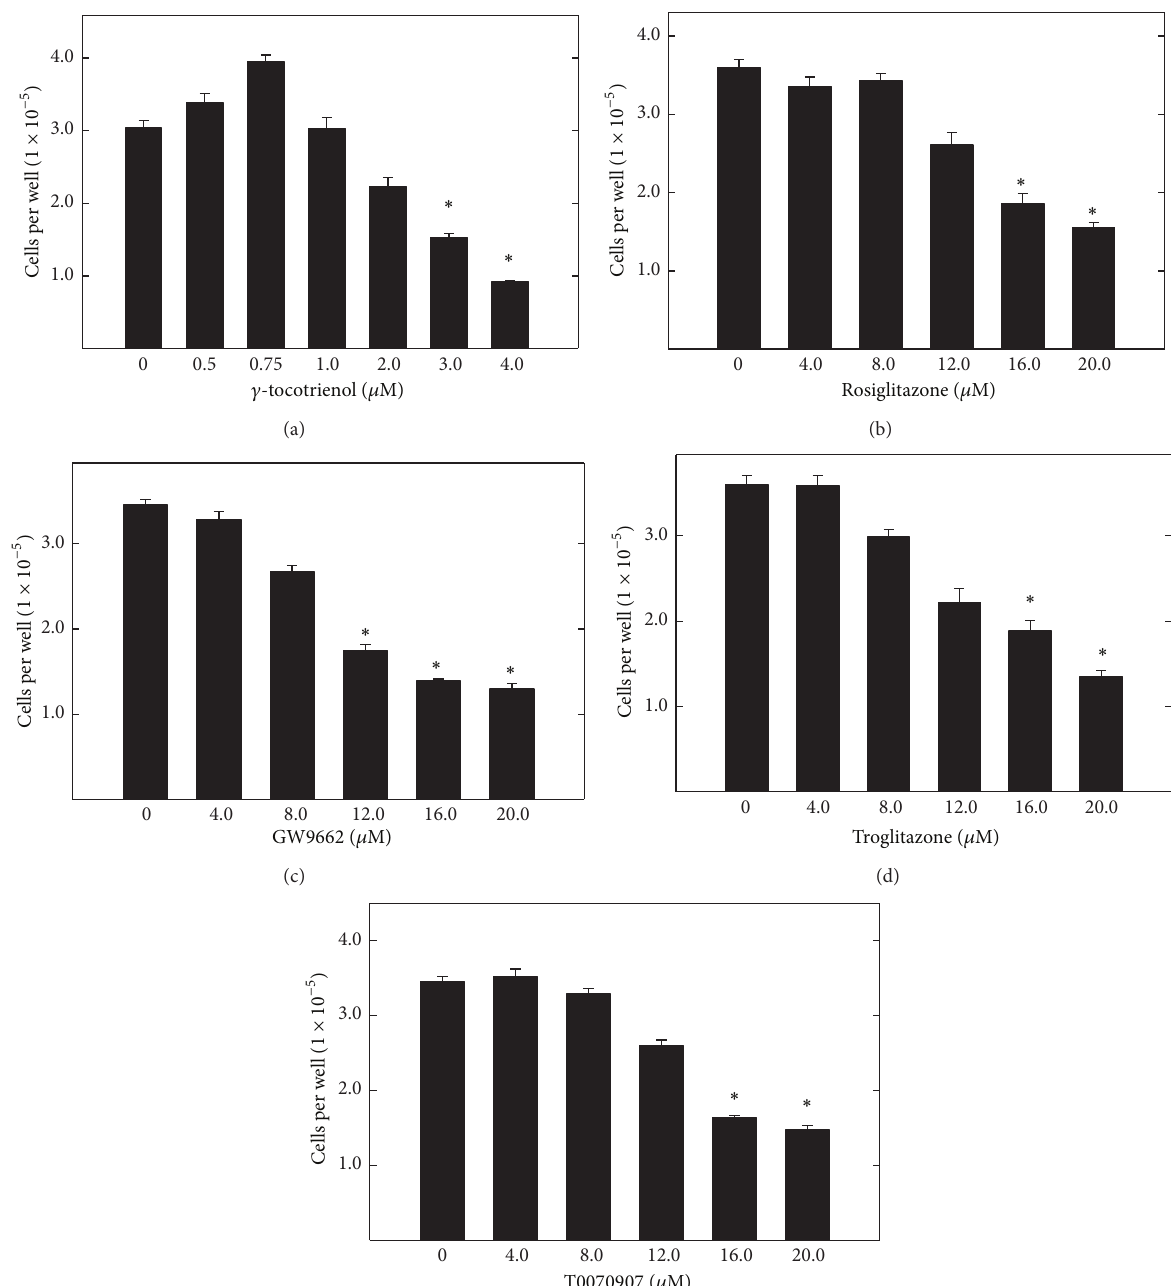
Figure 1: Treatment effects of 𝛾 -tocotrienol, PPAR 𝛾 agonists, and PPAR 𝛾 antagonists on +SA cells. +SA cells were plated at a density of 5 × 1 0 4 (6 wells per group) in 24-well culture plates and exposed to treatment media for a 4-day period. Afterwards viable cell number was determined using MTT colorimetric assay. Vertical bars indicate mean cell count ± SEM in each treatment group. ∗ 𝑃 < 0.05 as compared with vehicle-treated